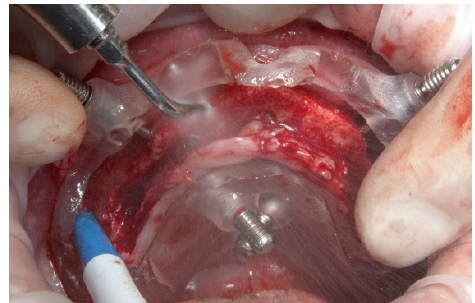
Figure 10. Base-portion in the patient’s mouth used as reference guide during the bone reduction.